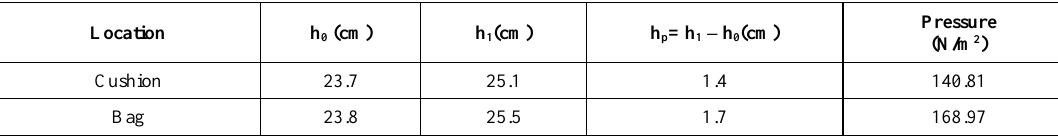
Table 3. Manometer reading of skirt